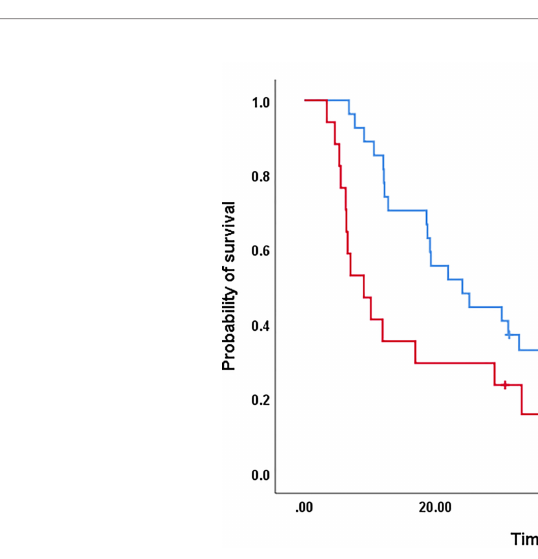
FIGURE 5 | Kaplan – Meier survival curves of OS by ECOG PS score for all patients. The OS of PS score of 0-1 was signi fi cantly better than that of PS=2 (median: 24.1 months vs. 9.1 months; P=0.029). OS, overall survival; ECOG PS, Eastern Cooperative Oncology Group performance status; CI, con fi dence